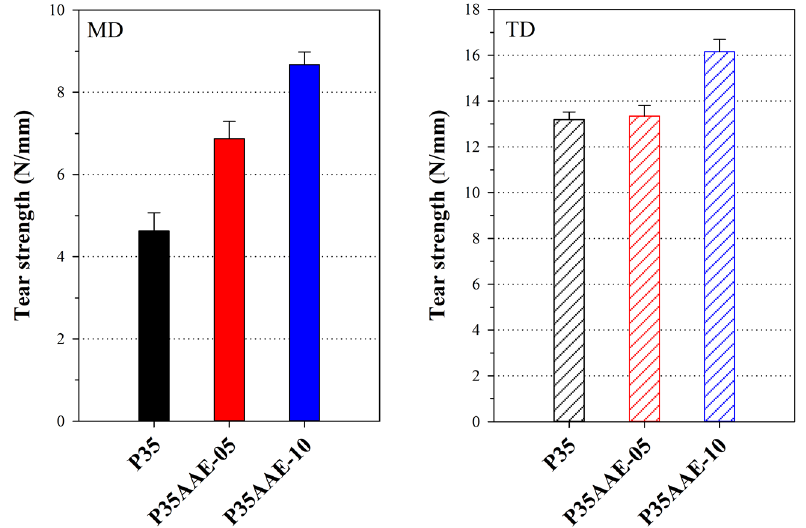
Figure 6. Tear strength of the neat PLA / PBAT and the plasticized PLA / PBAT blown film.